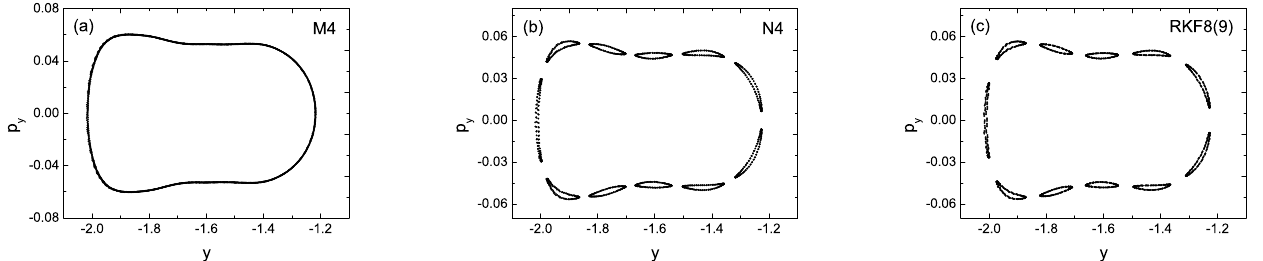
Figure 3. Poincaré sections at the plane x = 0 and p x > 0. The Poincaré sections in ( a ), ( b ) and ( c ) are respectively described by the three algorithms M4, N4 and RKF8(9). The integrators M4 and N4 with the larger time step τ = 0.1 are respectively used to act on the orbit tested in Figure 1. M4 gives a single torus to the orbit, but N4 like RKF8(9) exhibits many islands. The result is reliable for N4, but is not for M4 because the larger time step τ = 0.1 causes M4 to yield poor accuracy to the numerical